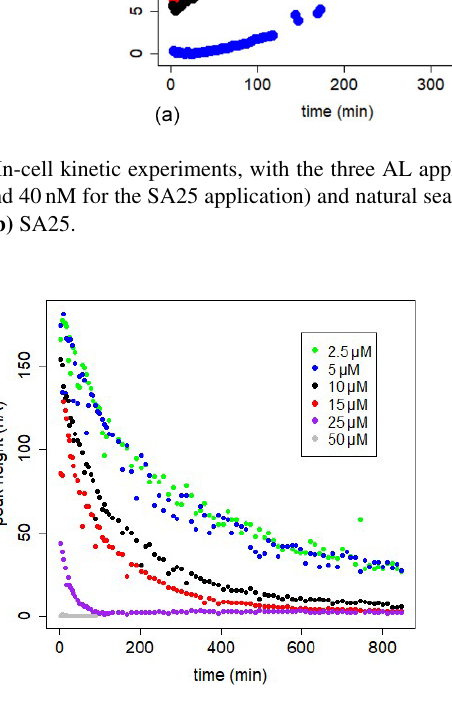
Figure 4. In-cell kinetic experiments at different [SA] in UV- irradiated seawater, peak heights versus time. Measurements versus time are done in the same 10mL, using the Metrohm electrode; drop size = 1, with regular purging with air. At t = 0 SA was